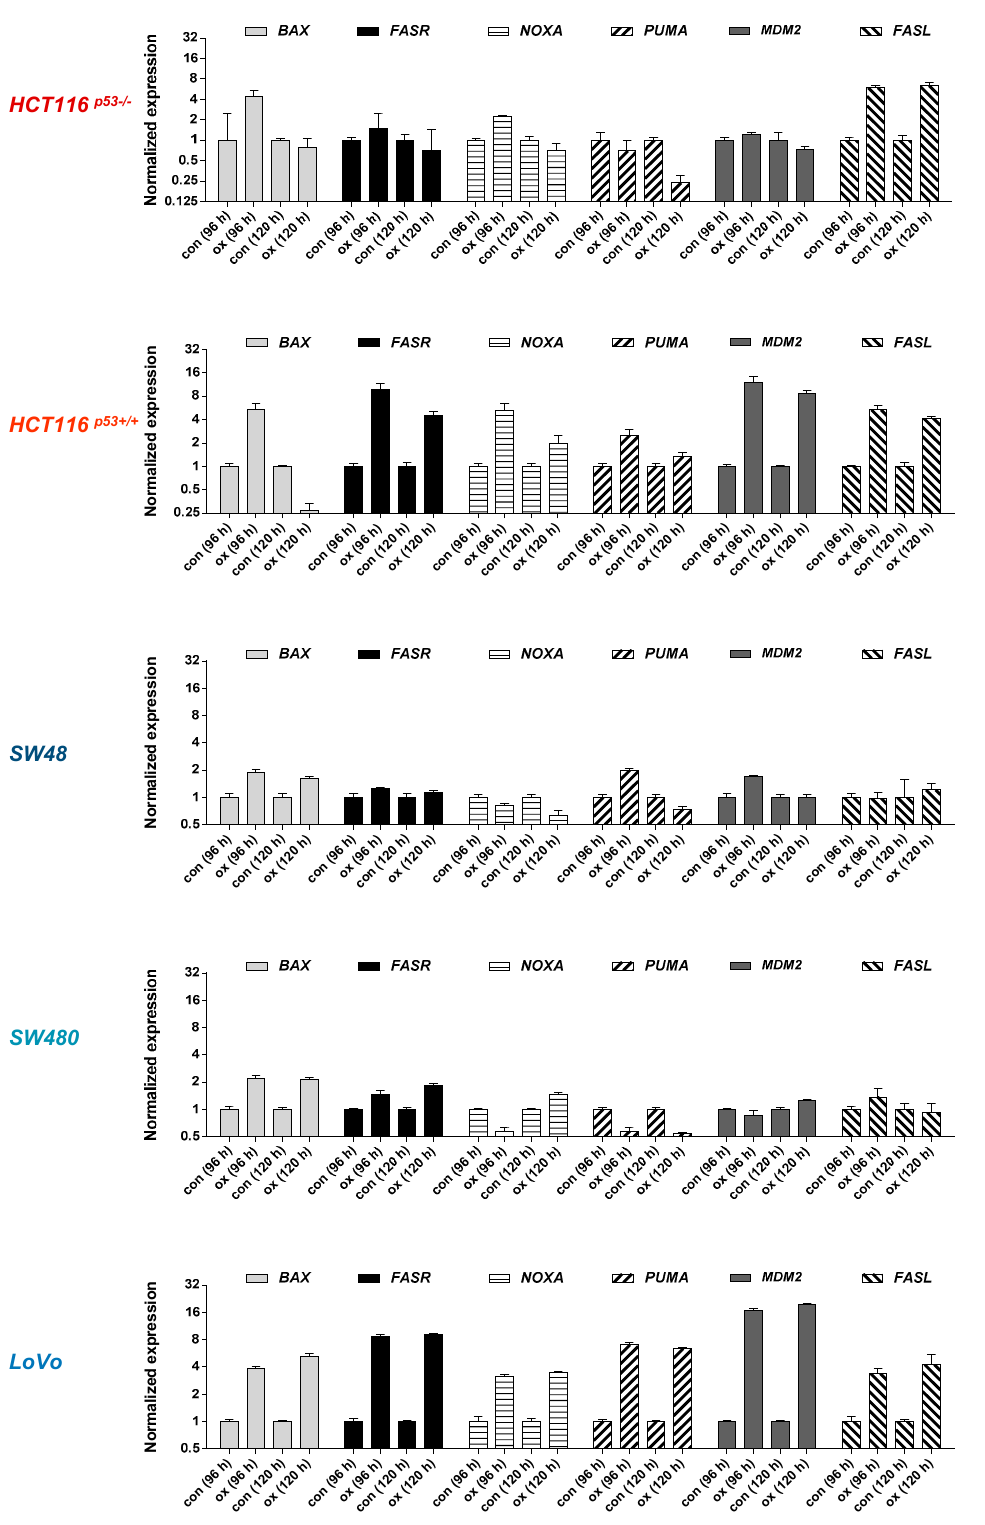
Figure A3. CRC cells were treated with 2.5 µ M oxaliplatin. 96 and 120 h later, expression of the pro-apoptotic factors BAX , FASR , NOXA , PUMA , FASL , and of the p53 target MDM2 was measured by qPCR.